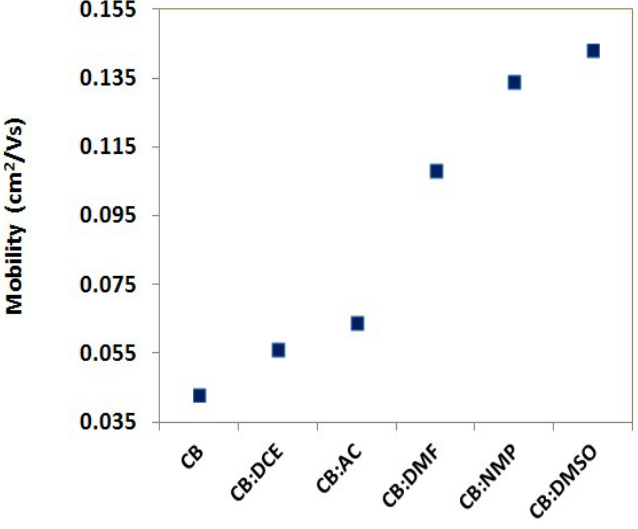
Figure 5. Charge carrier mobility of the samples.